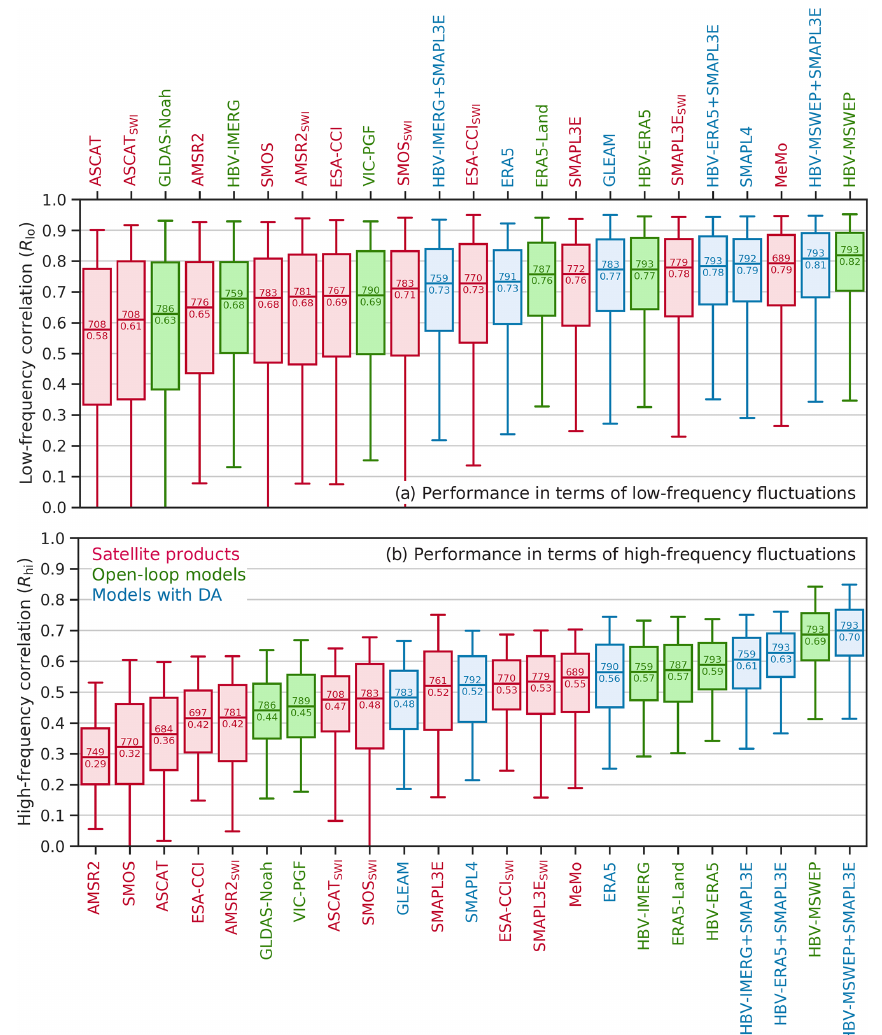
Figure 4. Performance of the soil moisture products in terms of 3-hourly Pearson correlation for (a) low-frequency fluctuations ( R lo ) and (b) high-frequency fluctuations ( R hi ). The products were sorted in ascending order of the median. The number above the median line in each box represents the number of sites with R lo or R hi values, and the number below the median line represents the median R lo or R hi value. Outliers are not